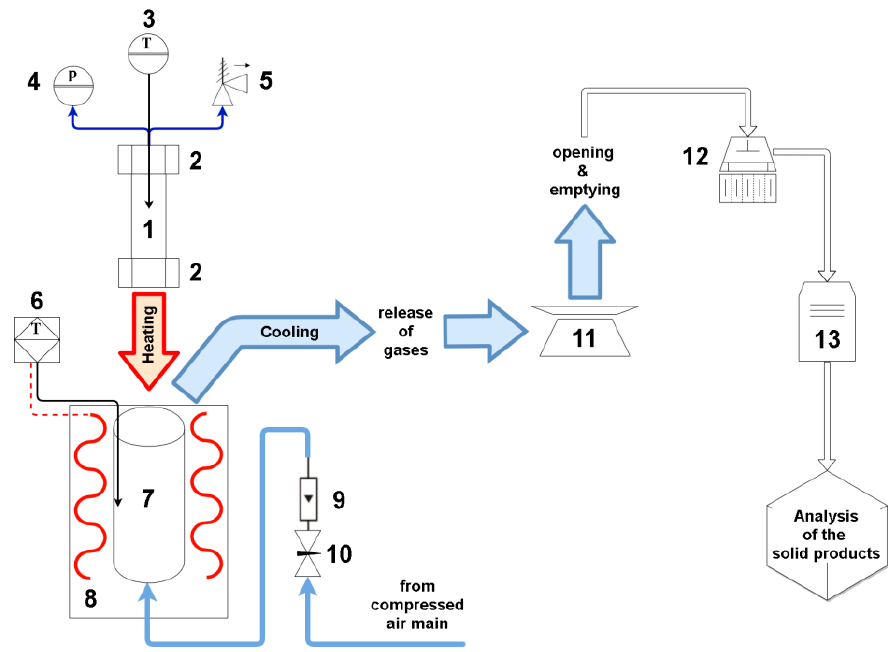
Figure 1. Hydrothermal carbonization test rig: 1—autoclave; 2—fittings able to withstand the pressure; 3—thermocouple; 4—pressure sensor; 5—safety valve; 6—thermocouple measuring the temperature inside of the hot fluidized bed; 7—fluidized bed used for heating the autoclave; 8—band heaters; 9—flow meter; 10—needle valve; 11—balance; 12—hydraulic press for dewatering; 13—oven for drying.